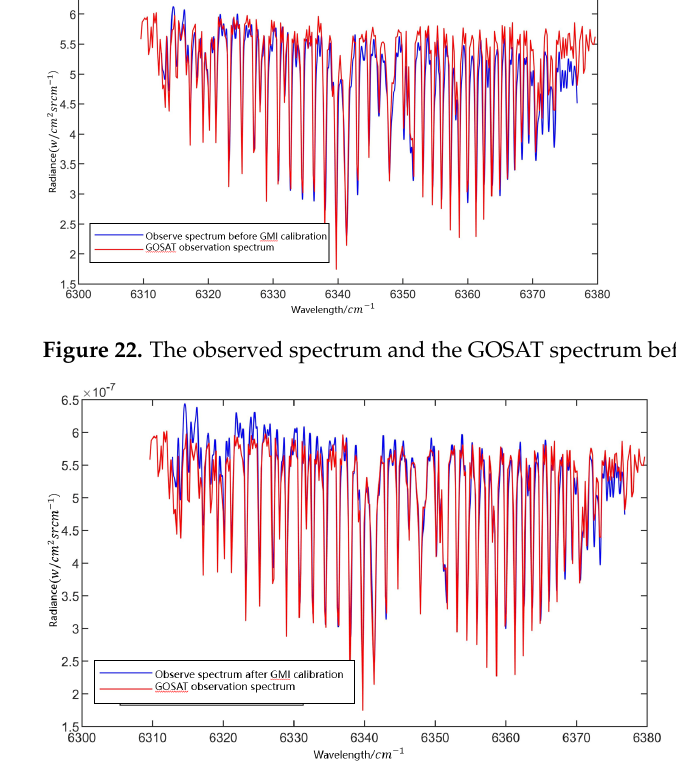
Figure 23. The observed spectrum and the GOSAT spectrum after the GMI calibration.